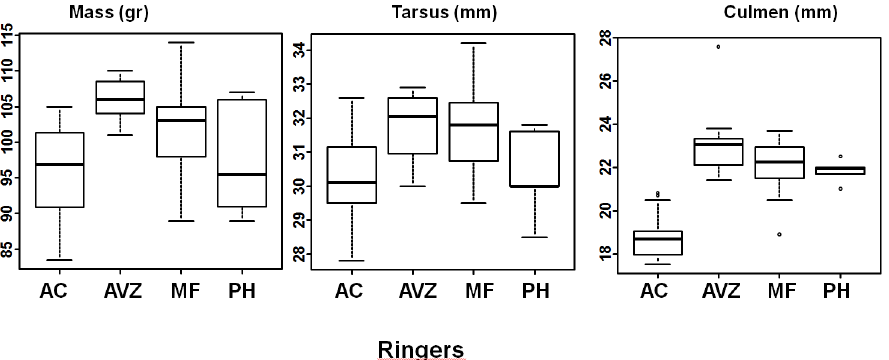
Fig 1. Differences of morphological measurements between ringers. Box plots of mass, tarsus and culmen data recorded by the four ringers over two